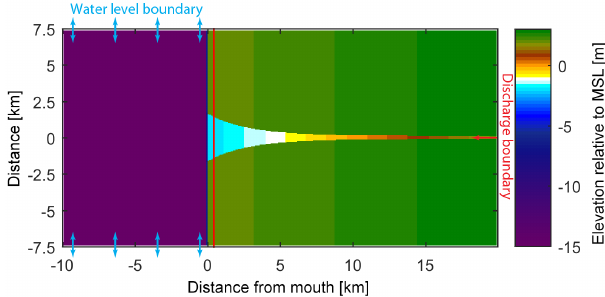
Figure 2. Initial bathymetry with model boundaries and cross sec- tion (red line) for analysis. Initial depth increases linearly upstream and width decreases exponentially (Eq. 8). Coordinates are defined at the coastline with the channel centreline and mean sea level (MSL) as